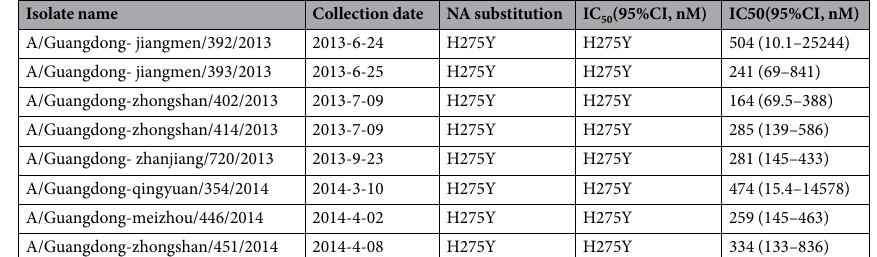
Table 4. Susceptibility of eight influenza A(H1N1)pdm2009 viruses with the H275Y substitutions to oseltamivir(Guangdong, China isolates from 2013 to 2014) “CI” = “Confidience Intervals”.